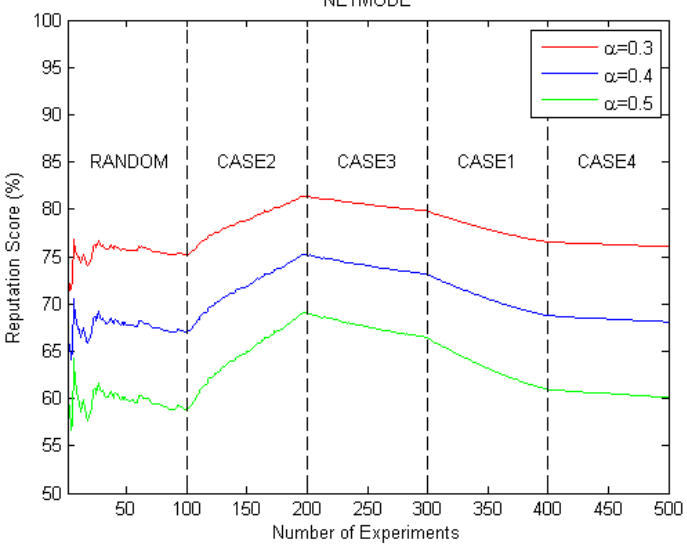
Figure 4. The effect of the α parameter on the modified fuzzy VIKOR